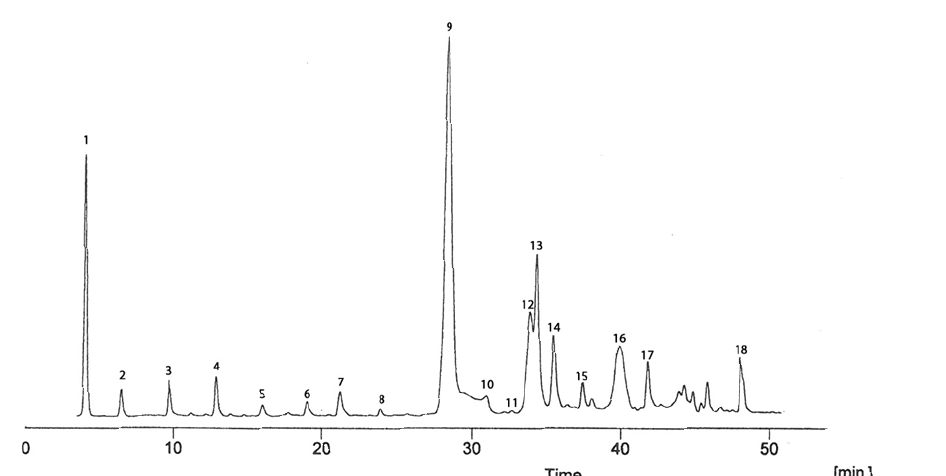
Fig. 1: Gallic acid (std) (1), hydroxytyrosol (2), tyrosol (3), vanillic acid (4), 4-hydroxybenzoic acid (5), p-coumaric acid (6), ferulic acid (7), o-coumaric acid (8), dialdehydic form decarboxymethyl oleuropein aglycon (9), oleuropein aglycon (10), cinnamic acid (11), dialdehydic form decarboxymethyl ligustroside aglycon (12), (+) pinoresinol (13), (+) 1-acetopinoresinol (14), luteolin (15), dialdehydic form oleuropein aglycon (16), apigenin (17), hydroxytyrosol acetate, dialdehydic form ligstroside aglycon